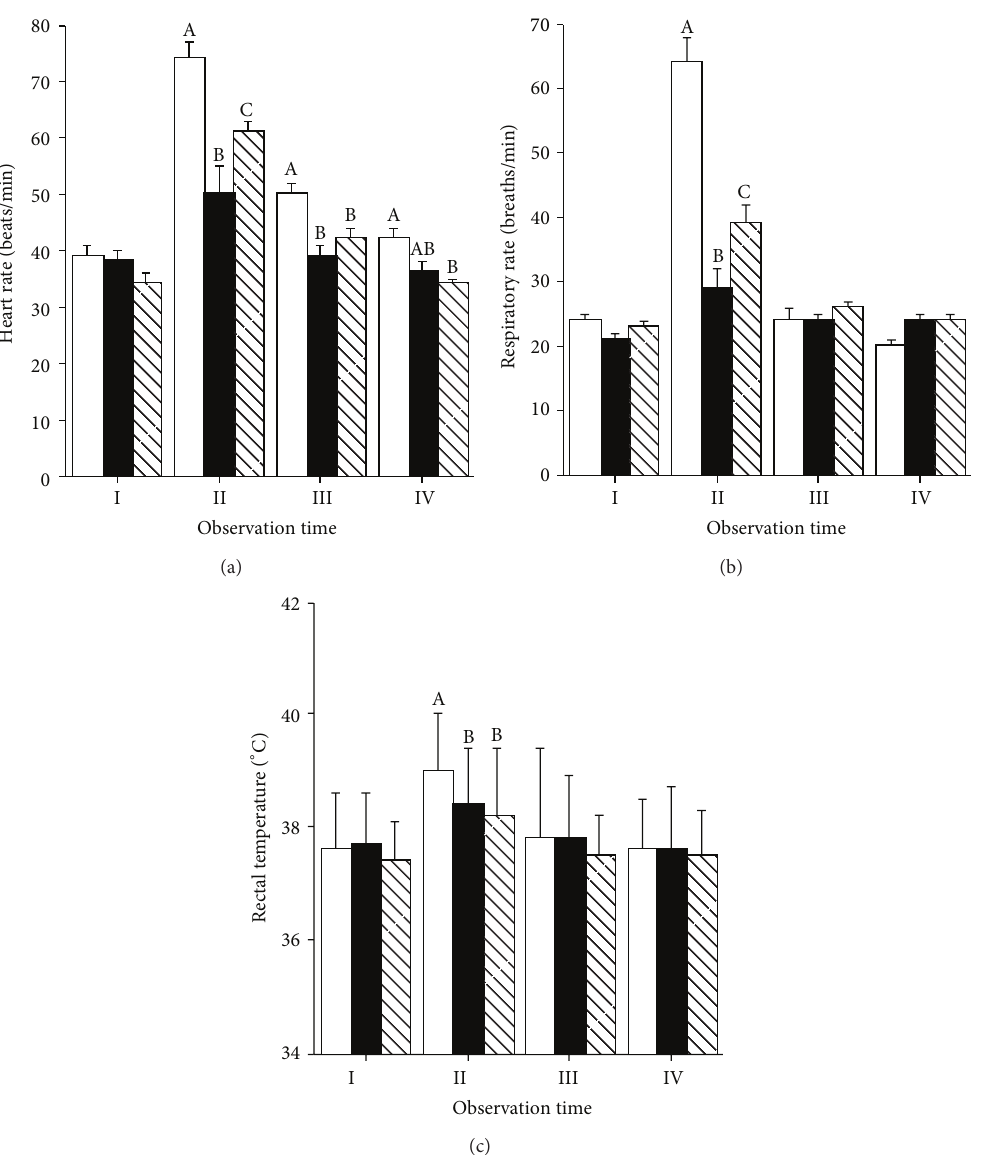
Figure 1: Effect of different types of physical exercise (race blank; maximal exercise shaded; daily exercise lined) on heart rate (a), respiratory rate (b), and rectal temperature (c) of Standardbred horses housed in single stalls. Mares were examined at rest in their stalls (Time I), immediately after exercise (Time II), one (Time III), and two hours (Time V) after the completion of exercise. Values are expressed as means ± SE. For parameters where a significant effect of type of exercise × time interaction was noted, means with different capital letters indicate significant difference ( 𝑃 < 0.01 ) between types of